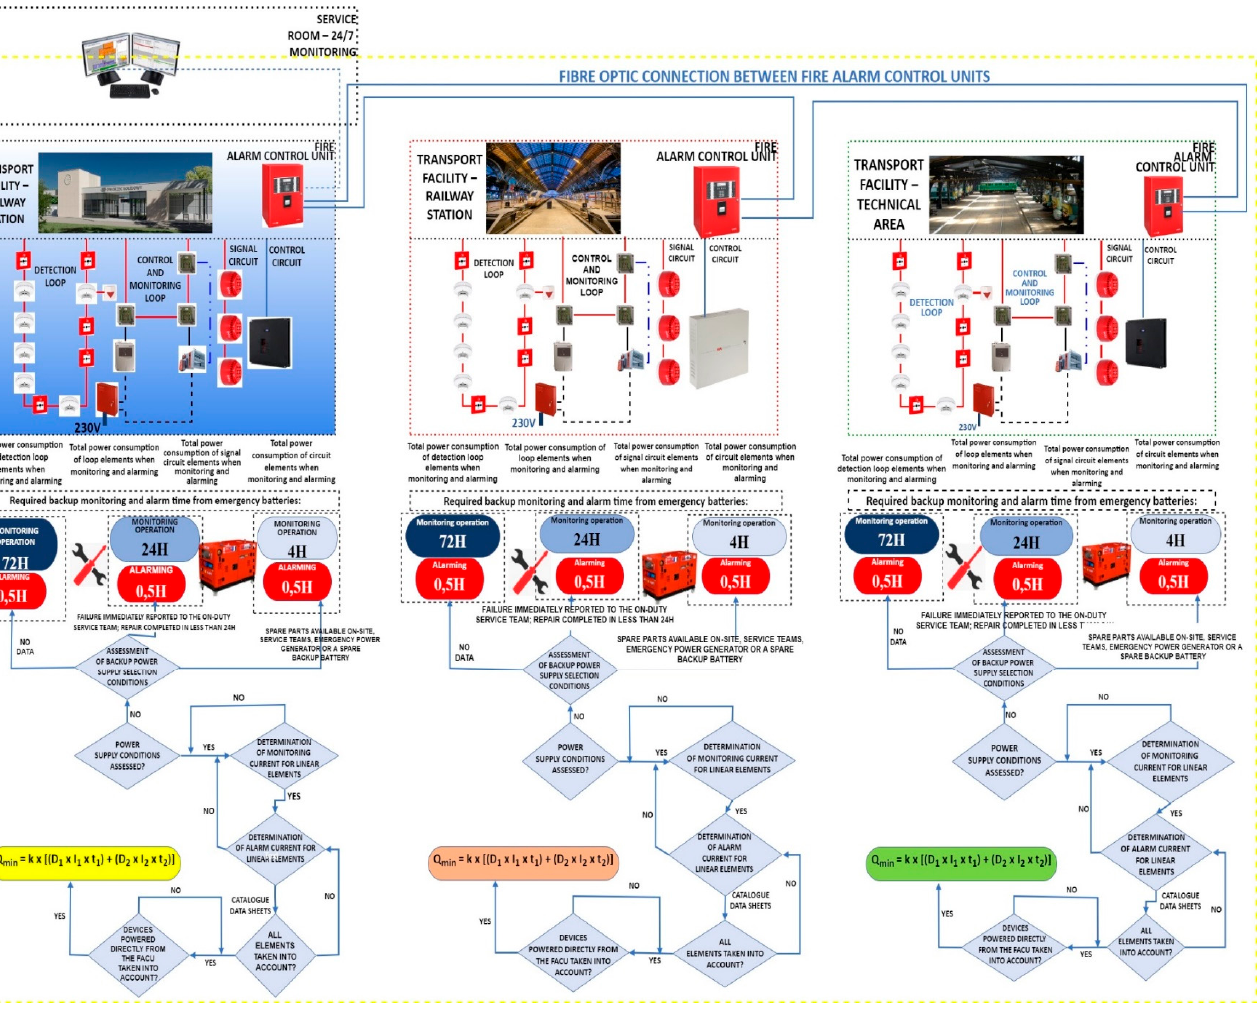
Figure 4. Scattered FAS energy balance determination graph, where: k is reserve coefficient, usually taken as 1.25, I 1 a-determined FAS power consumption in the technical state of monitoring for the first fire system, t 1 a-required operating time of the first FAS in the technical state of monitoring, D 1 a-coefficient associated